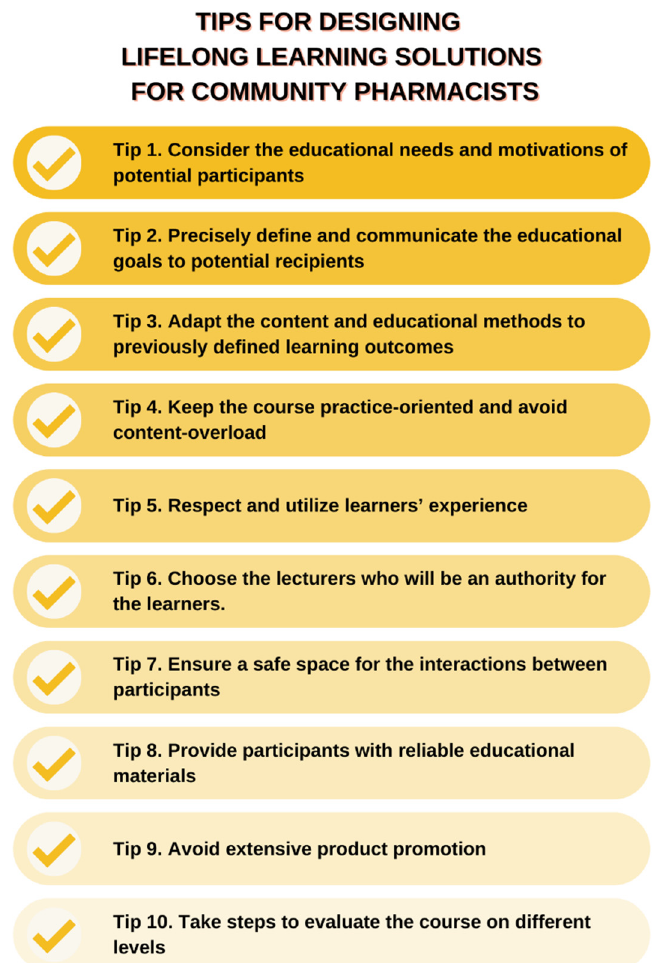
Figure 3. Ten tips for designing lifelong learning solutions for community